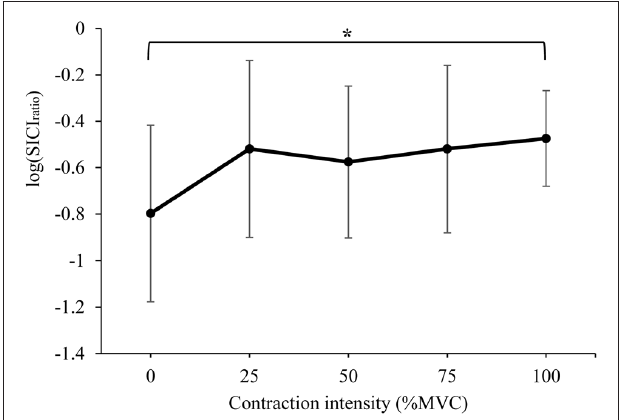
FIGURE 3 | Mean ± SD short-interval intracortical inhibition (SICI) ratio recorded from the resting right RF during isometric contraction of the left quadriceps. ∗ Denotes significant difference in post hoc pairwise comparison ( p < 0.05). Contractions at 100% MVC resulted in a 65% increase in the SICI ratio (from 0.23 to 0.38 of unconditioned MEP).